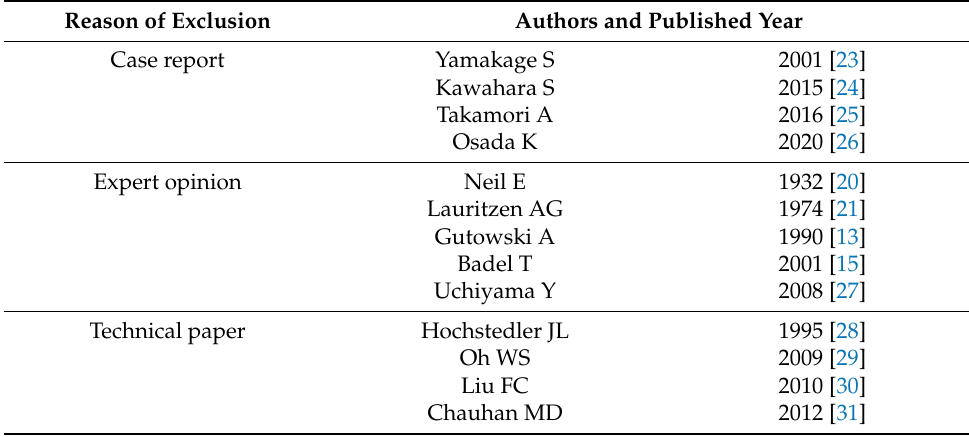
Figure 1. The diagram of the inclusion process. Table 2. The excluded articles [13,15,20,21,23–31].